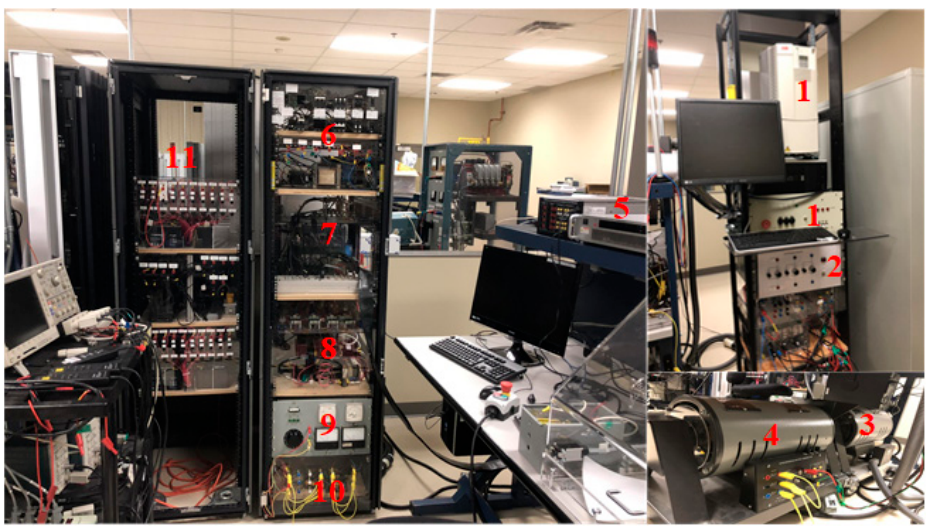
Figure 6. Hardware prototype of a standalone microgrid.